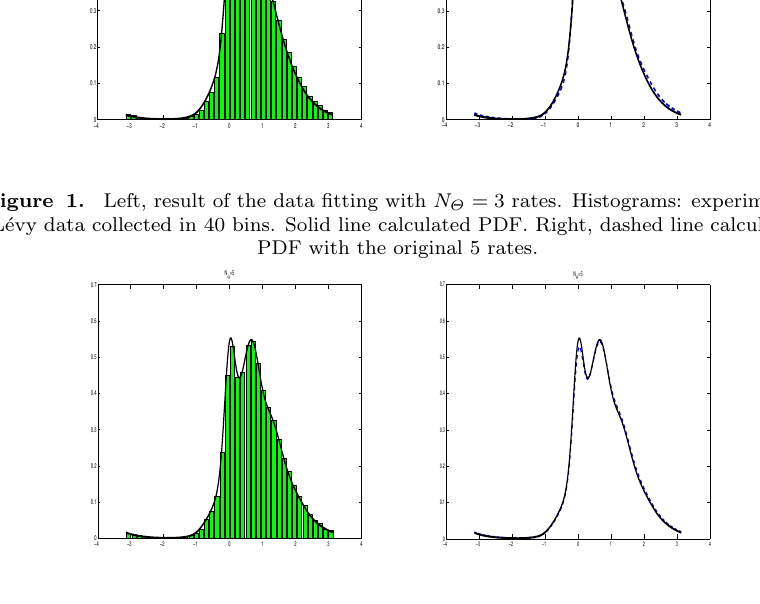
Figure 2. Left, result of the data fitting with N Θ = 5 rates. Histograms: experimental L´evy data collected in 40 bins. Solid line calculated PDF. Right, dashed line calculated PDF with the original 5 rates.